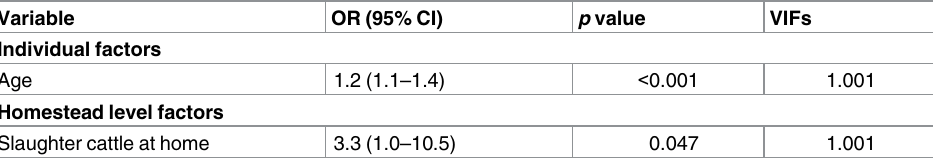
Table 2. Results of multi-level analysis for risk factors for RVFV seropositivity in the